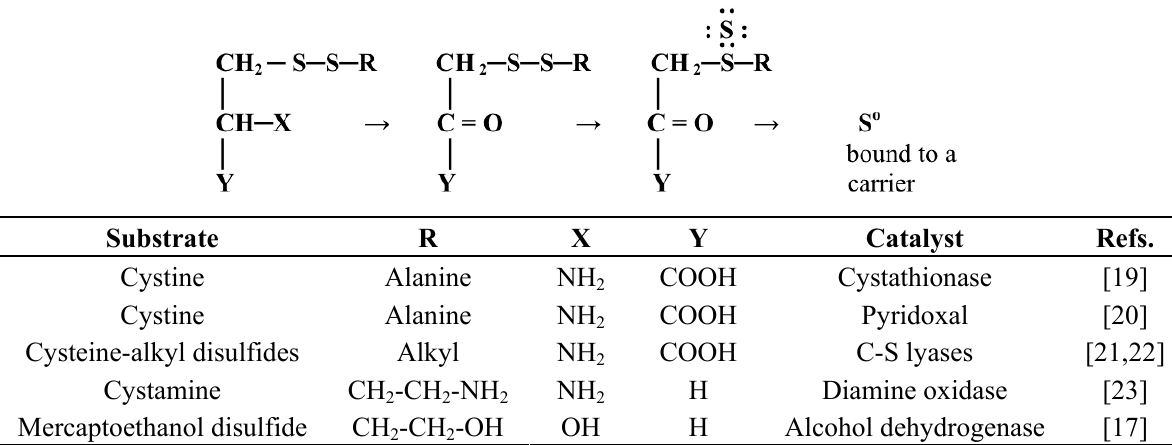
Table 2. Physiologically compatible systems which generate sulfane sulfur from